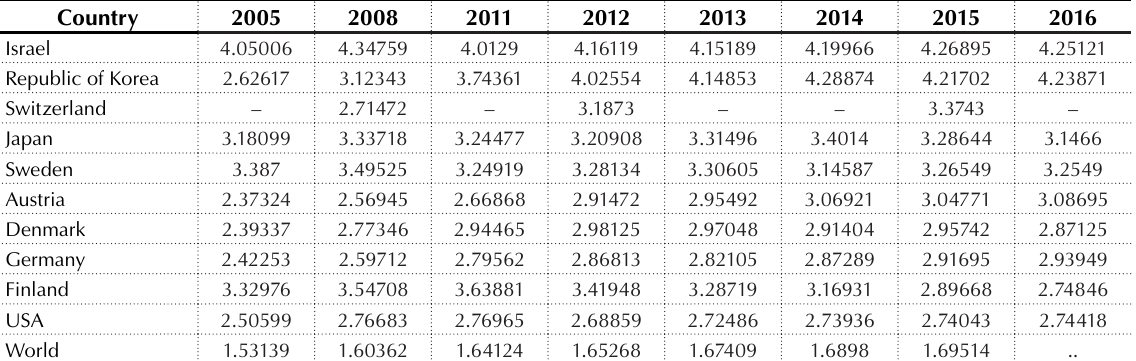
Table 5. ТOP-10 countries by expenditures on R&D, GDP (2005–2016), %